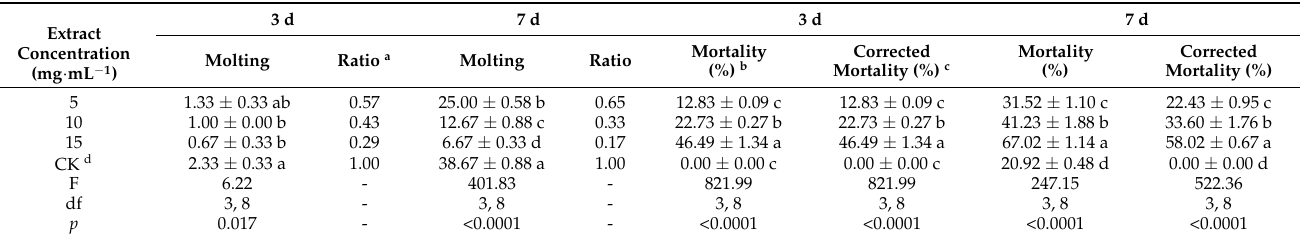
Table 5. Mean molting and mortality ( ± SE) of M. sorghi after 3 d and 7 d of treatment with different concentrations of GSE.